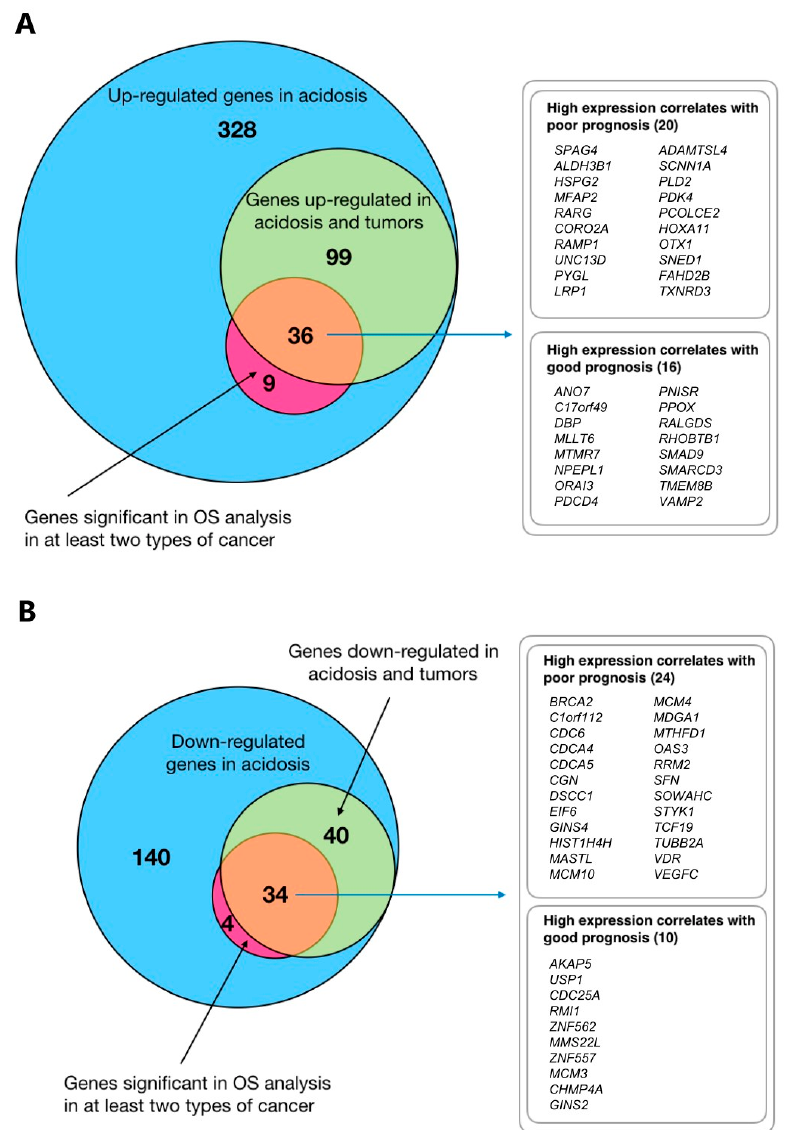
Figure 6. Integrative analysis. ( A ) Overlaps between upregulated genes, OS and RRHO analyses. Venn diagrams show overlaps between acid adaptation-upregulated genes (from Figure 2B), of genes significant in overall survival (OS) analysis in at least two types of cancer (based on TCGA data, Figure 4), and genes identified as having significant rank correlations between acid adaptation and tumor-control gene rank lists (RRHO analysis, Figures 4 and 5). ( B ) Overlaps between downregulated genes, OS and RRHO analyses Venn diagrams arranged as in ( A ) but focused on acid adaptation-downregulated genes.